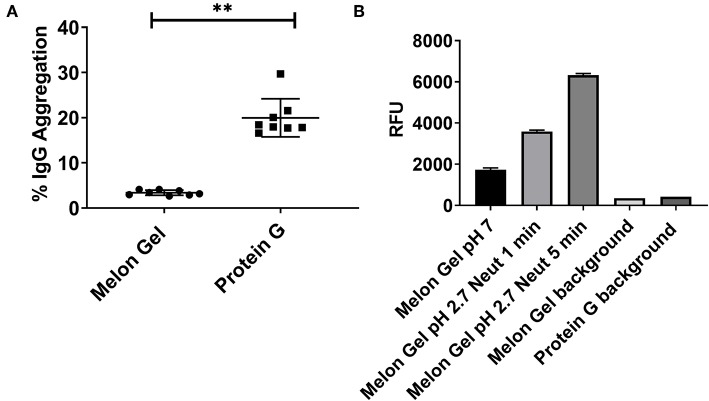
(A) Median + IQR IgG aggregation observed from a set of n = 8 matched paired samples of plasma IgG purified via Melon Gel and Protein G. (B) Increasing fluorescence with low pH exposure of a Melon Gel sample after 1 and 5 min. Mean ± SD of a of duplicate samples, exposed to Protein G elution buffer (0.1 M glycine-HCl, pH 2.7) and then neutralized with 1 M Tris-HCl, pH 9.0.